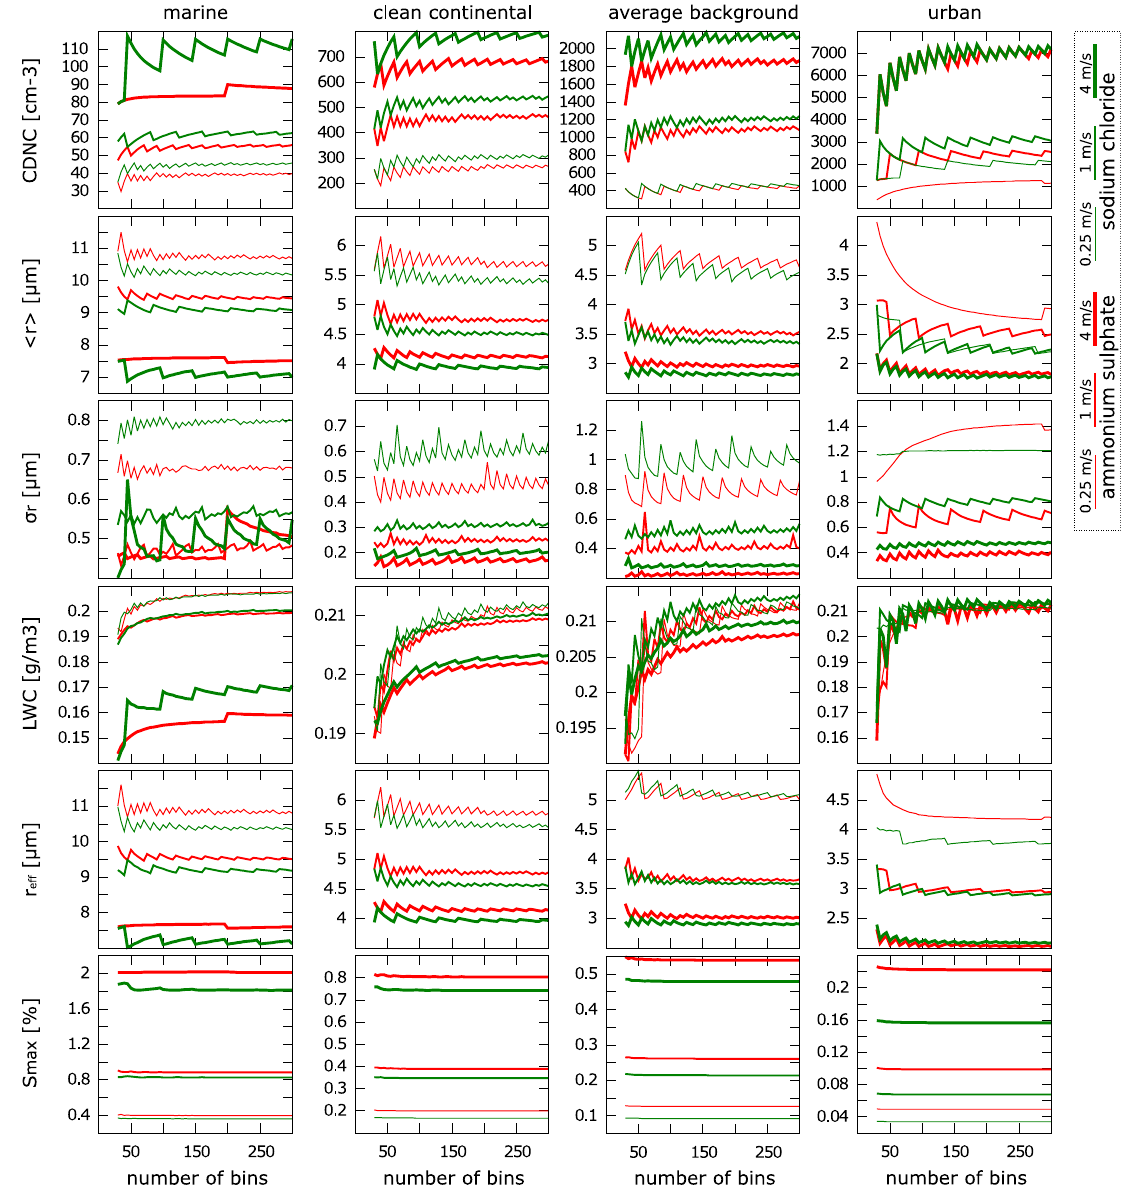
Fig. 4. A summary of results obtained without adaptivity in the 1296 model runs discussed in Sect. 3.2 (see text for details) plotted as a function of the number of bins. The lines are drawn by connecting points every 5bins. The width and colour of a line correspond to the vertical velocity and solute, respectively (cf. the key in the top-right corner of the figure). Each of the four columns of plots corresponds to a different initial aerosol size spectrum (i.e. marine, clean continental, average background and urban), all plots in a column share the x-axis. Each of the top five rows of plots corresponds to a droplet spectrum parameter (i.e. CDNC, <r> , σ r , LWC and r eff ). The bottom row of plots corresponds to the maximum supersaturation. The ranges of the y-axes differ. Figure 5 presents analogous results obtained with adaptivity (with maximum supersaturation plots